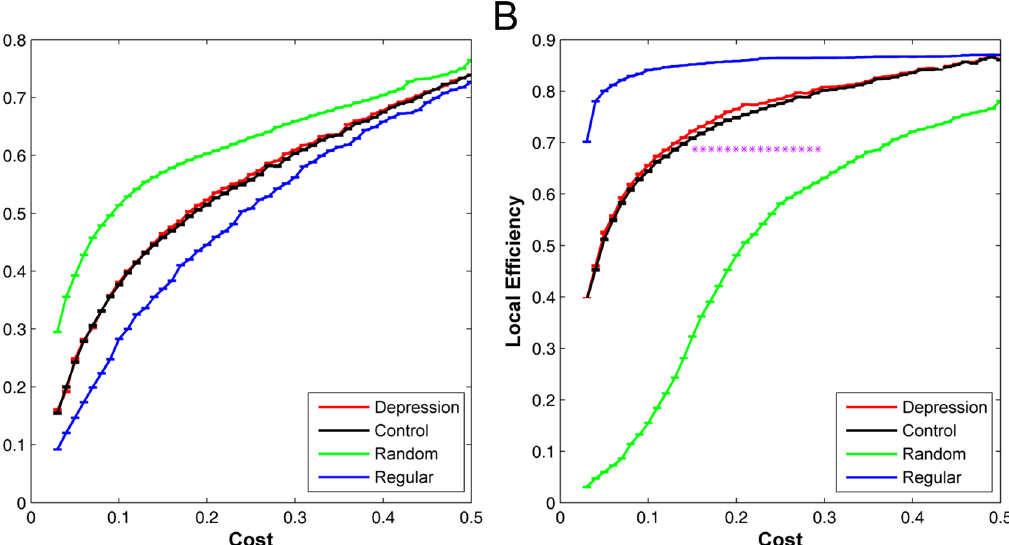
Fig 1. Small-world properties of functional brain networks. (A) global efficiency and (B) local efficiency over the whole range of 0.03~0.50 for random (green), regular (blue), and real networks (MDD patients: red; Healthy controls: black). Error bars corresponded to standard error of the mean. Purple stars indicated where the difference between MDD patients and healthy controls was significant ( p < 0.05). On average, both healthy controls and MDD patients showed small-world properties. Additionally, MDD patients showed higher local efficiencies at the range of 0.15~0.30 ( p <